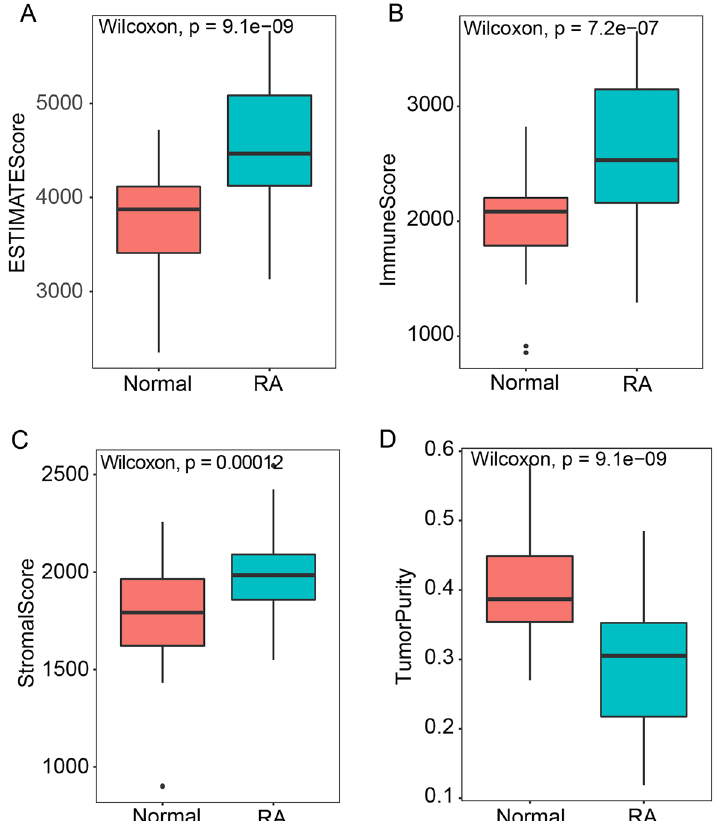
Figure 6. ESTIMATE analysis was performed between RA and controls. ( A ) Comparison of the ESTIMATE sore between RA and controls. ( B ) Comparison of the immune sore between RA and controls. ( C ) Comparison of the stromal sore between RA and controls. ( D ) Comparison of the tumor purity between RA and